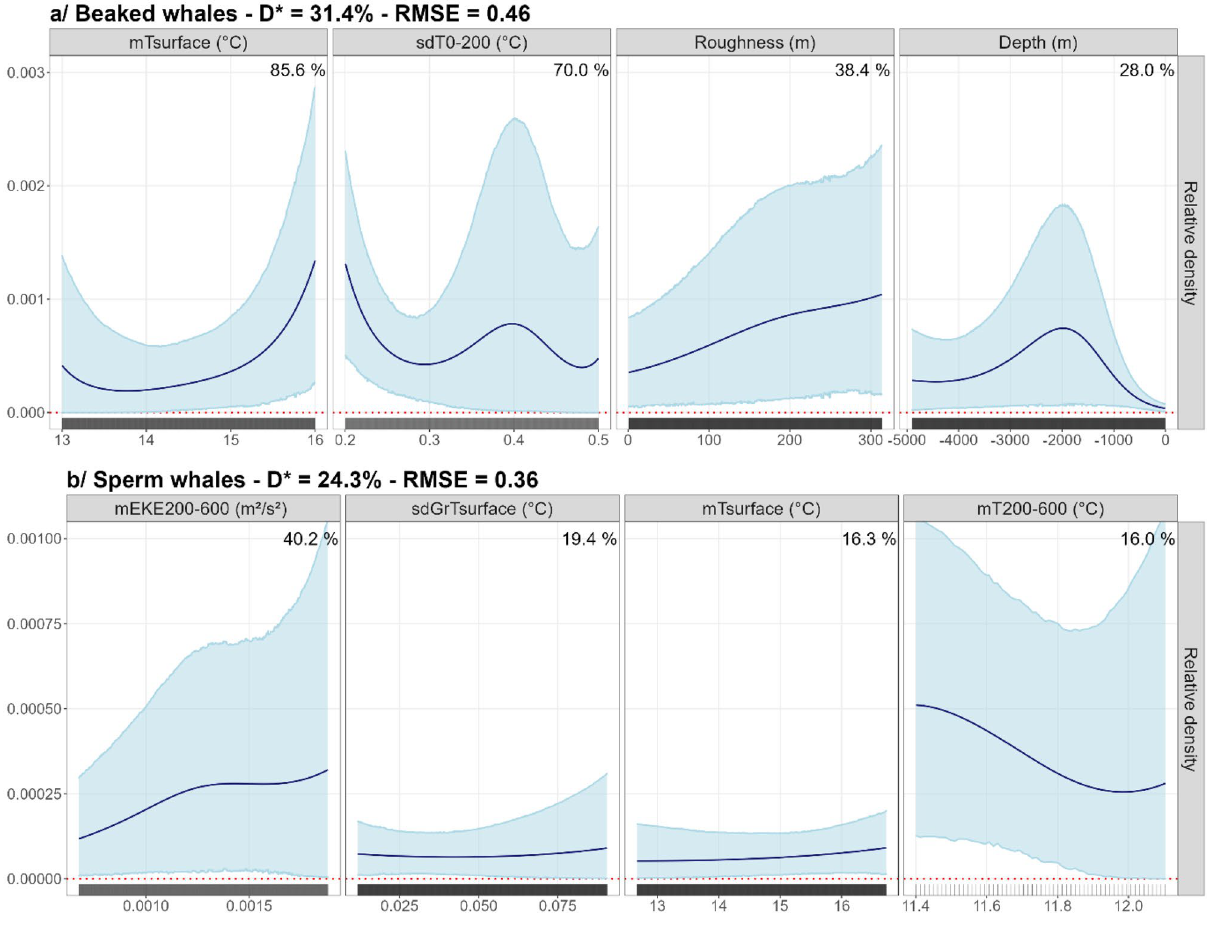
Figure 2. The functional relationships between beaked whale and sperm whale individual densities and the four most important and uncorrelated variables. Solid lines represent the estimated smooth functions and the blue shaded regions show the approximate 95% confidence intervals. The relative density of individuals (individuals per 100 km 2 ) is shown on the y-axis, where a zero indicates no effect of the covariate. The black rug plot on the x-axis represents the distribution of the data. The percentages indicate the importance of the variables calculated by summing the Akaike weights of the models in which they were selected. D*: explained deviance; T: temperature; GrT: gradients of temperature; EKE: eddy kinetic energy; m: mean; sd: standard